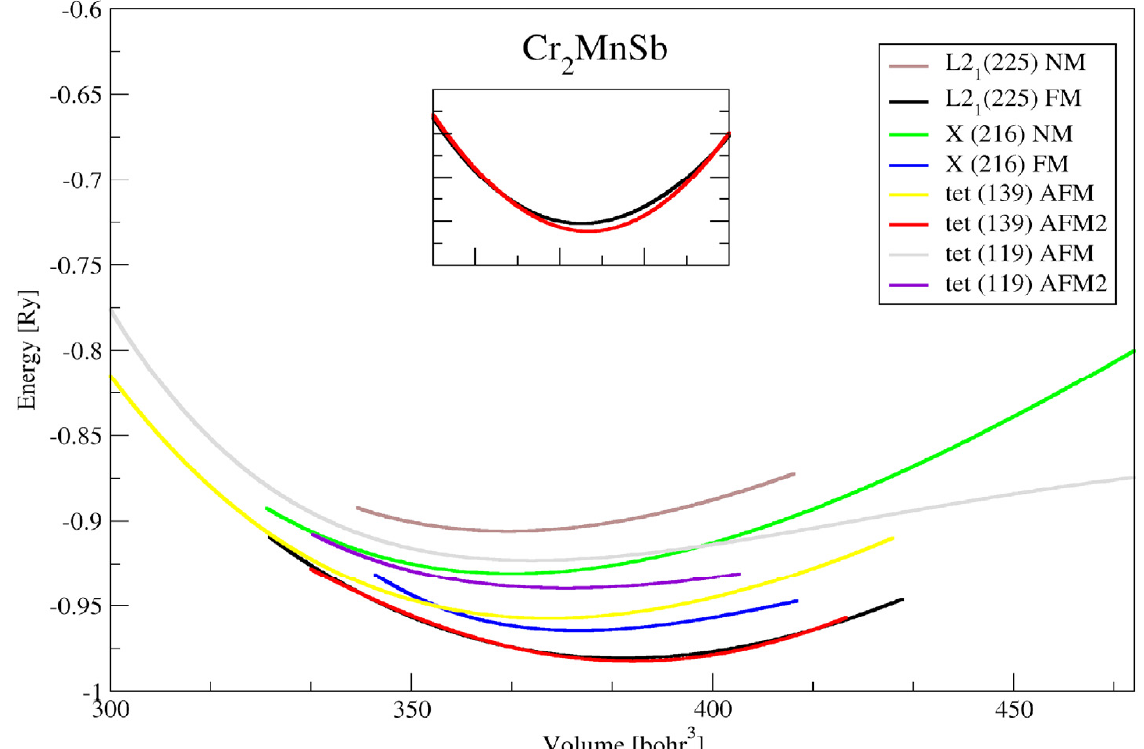
Figure 3. The total energy (Ry) versus volume (a.u. 3 ) for different crystal structures of Heusler Cr 2 MnSb.